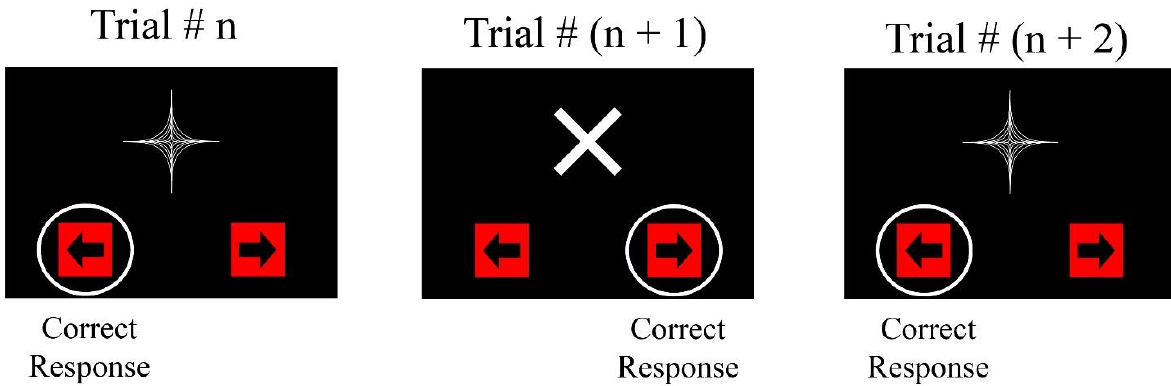
Example Trials for the Concurrent Visual Discrimination (CVD) Task